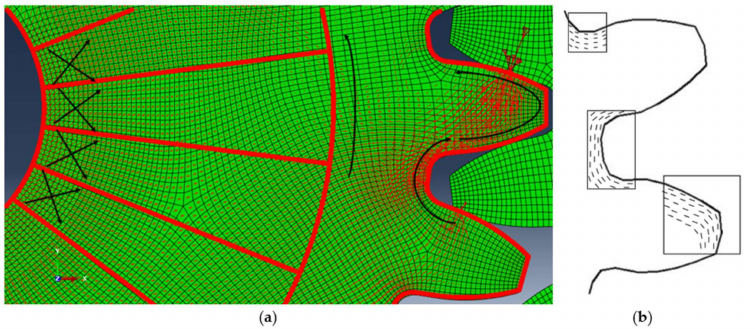
Figure 26. ( a ) Section division of spur gear for tool-path; ( b ) principal directions of teeth section.